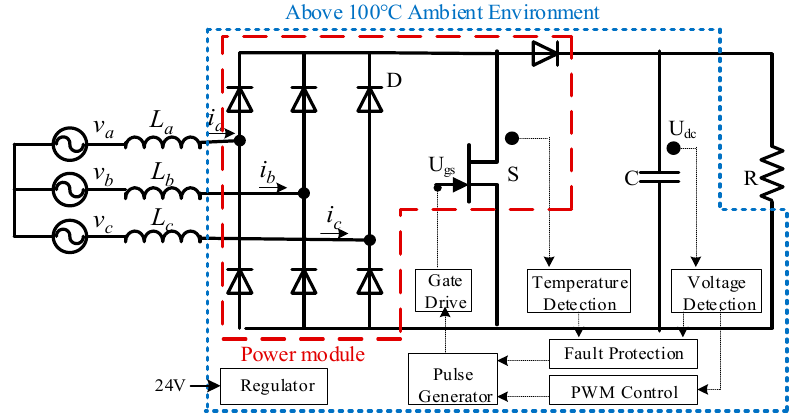
Figure 12. Hardware configuration diagram of the high-temperature three-phase AC–DC converter.